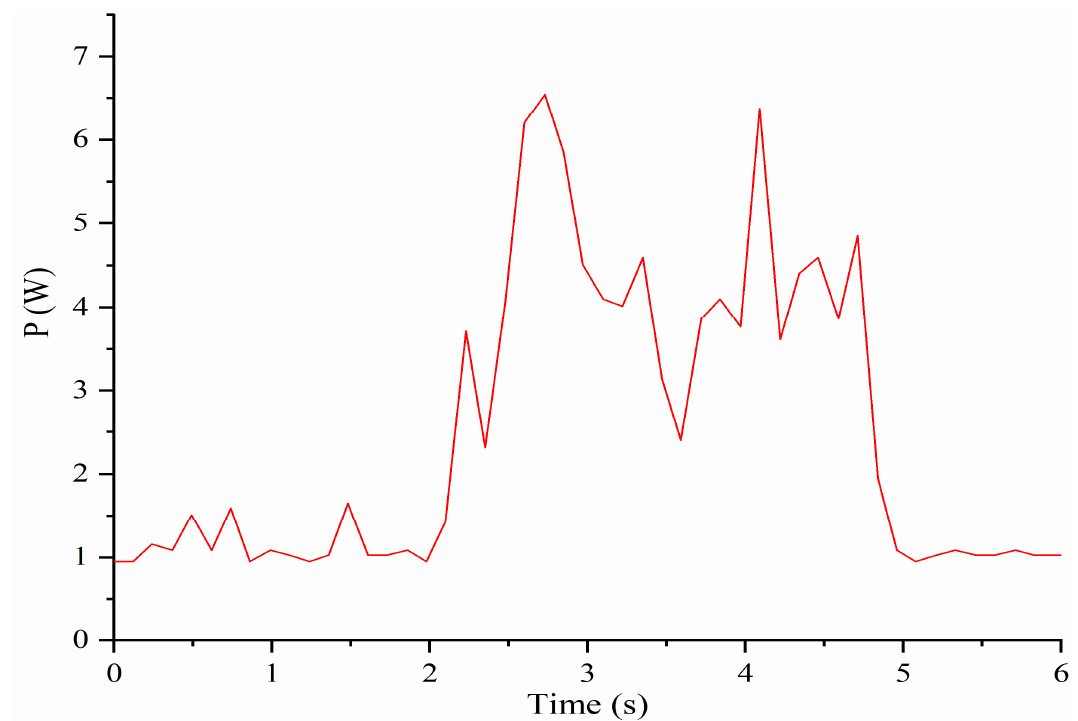
Figure 11. Computed power consumption of servomotors during full rotation testing, Table 2.